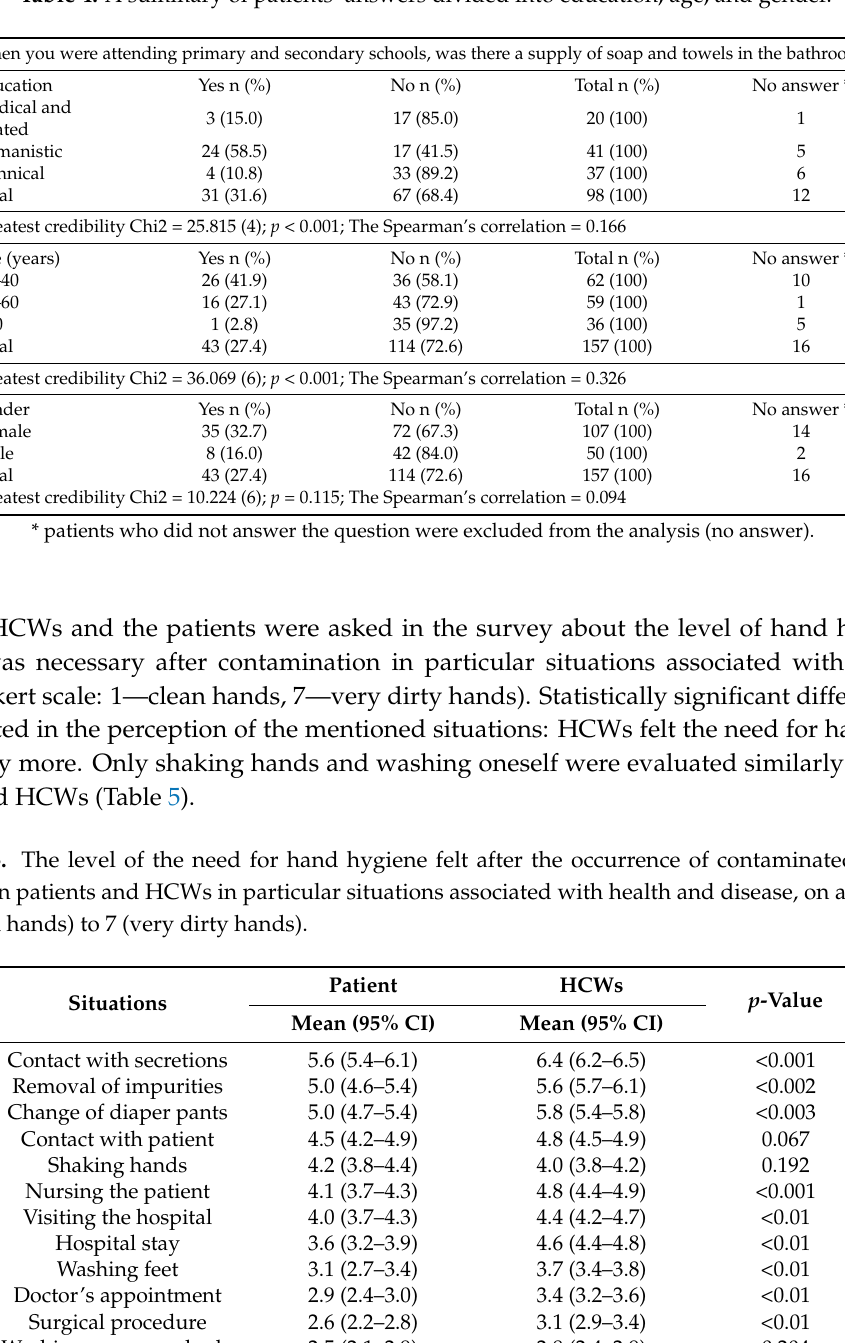
Table 4. A summary of patients’ answers divided into education, age, and gender.